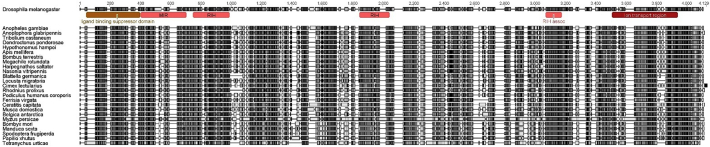
MAFFT alignment and Pfam domain map of annotated insect IP3R sequences.